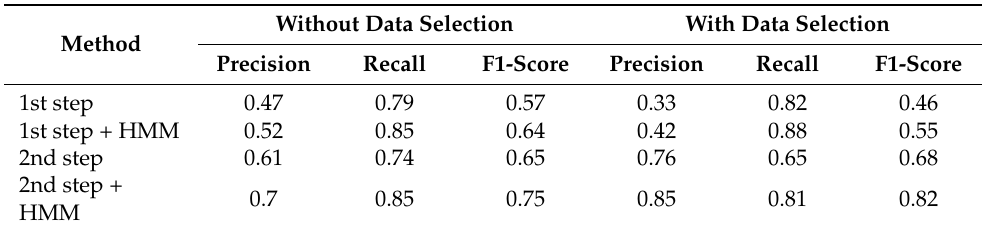
Table 3. Average precision, recall, and f1-score for each step used in the proposed method, with or without data selection. Leave-one-subject-out (LOSO) evaluation. Hidden Markov Model